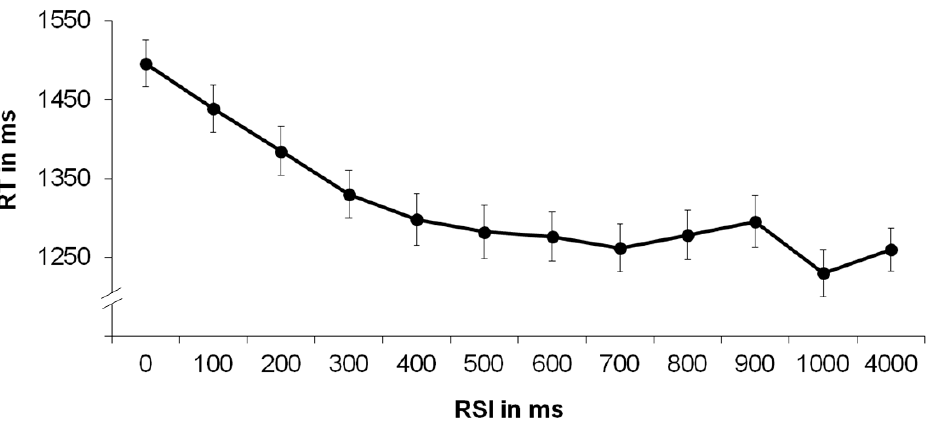
Figure 1. Mean reaction time (RT) (in ms) as a function of the duration of the response–stimulus interval (RSI) (in ms). interval (RSI) (in